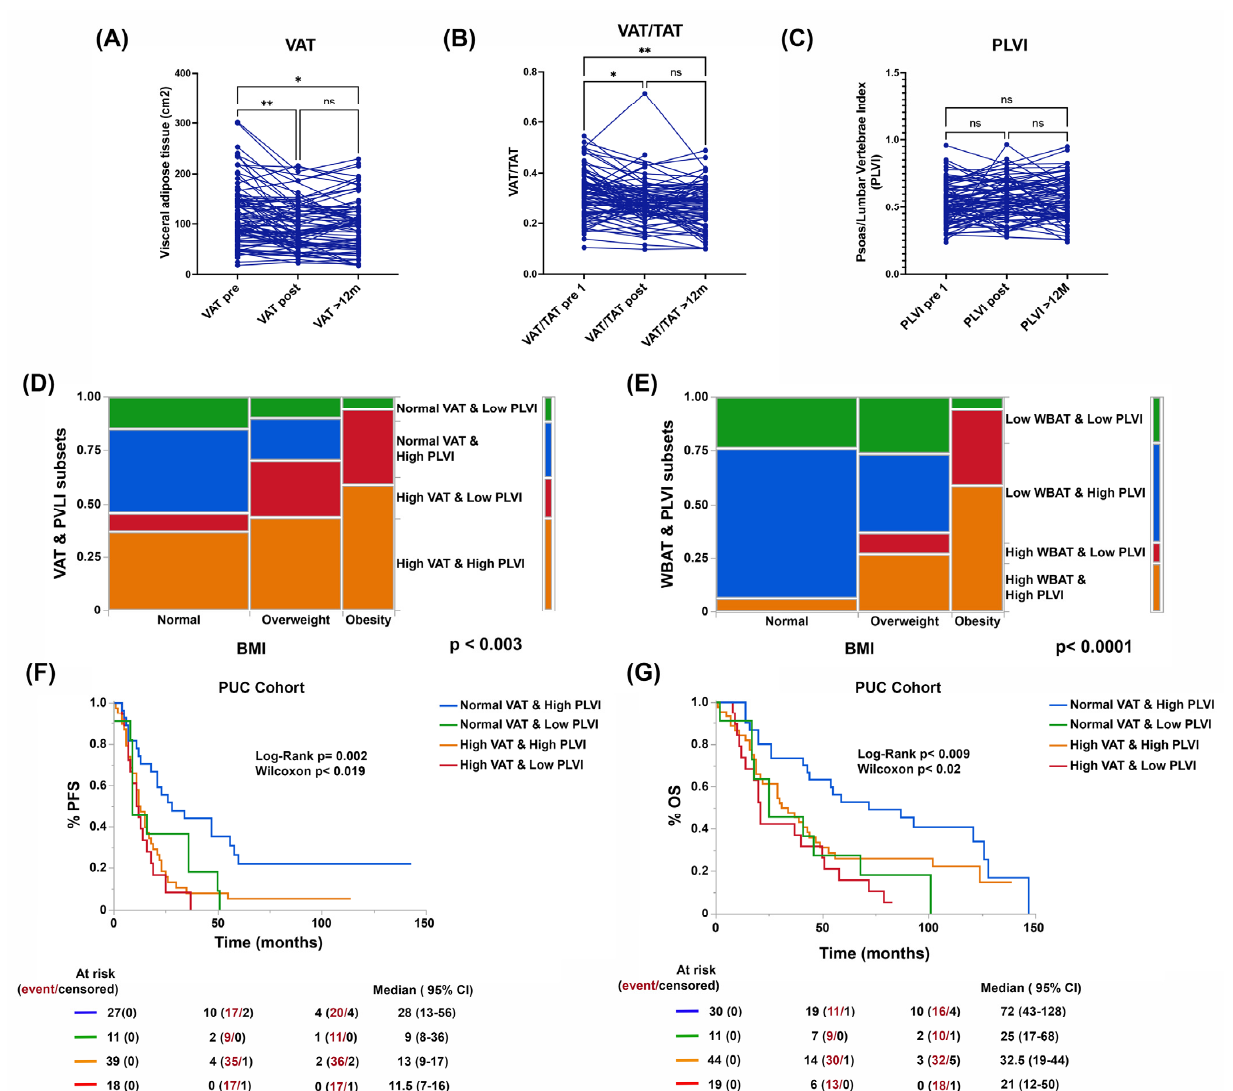
Figure 2. Trends in visceral adiposity (visceral to total adipose tissue [TAT] at the same level, A , B ) and PLVI ( C ) and prevalence of different body compositions (BCs) defined by VAT or WBAT and PLVI after front-line treatment ( D , E ) and its impact in PFS and OS ( F , G ) in the PUC cohort. The * and ** indicate statistical significance among the groups ( p < 0.001). ns stands for non-significant.